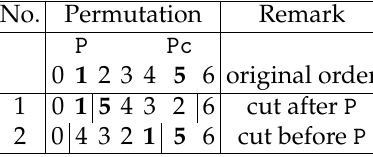
Table 3. List of possible 2-opt operations based on a 7-points